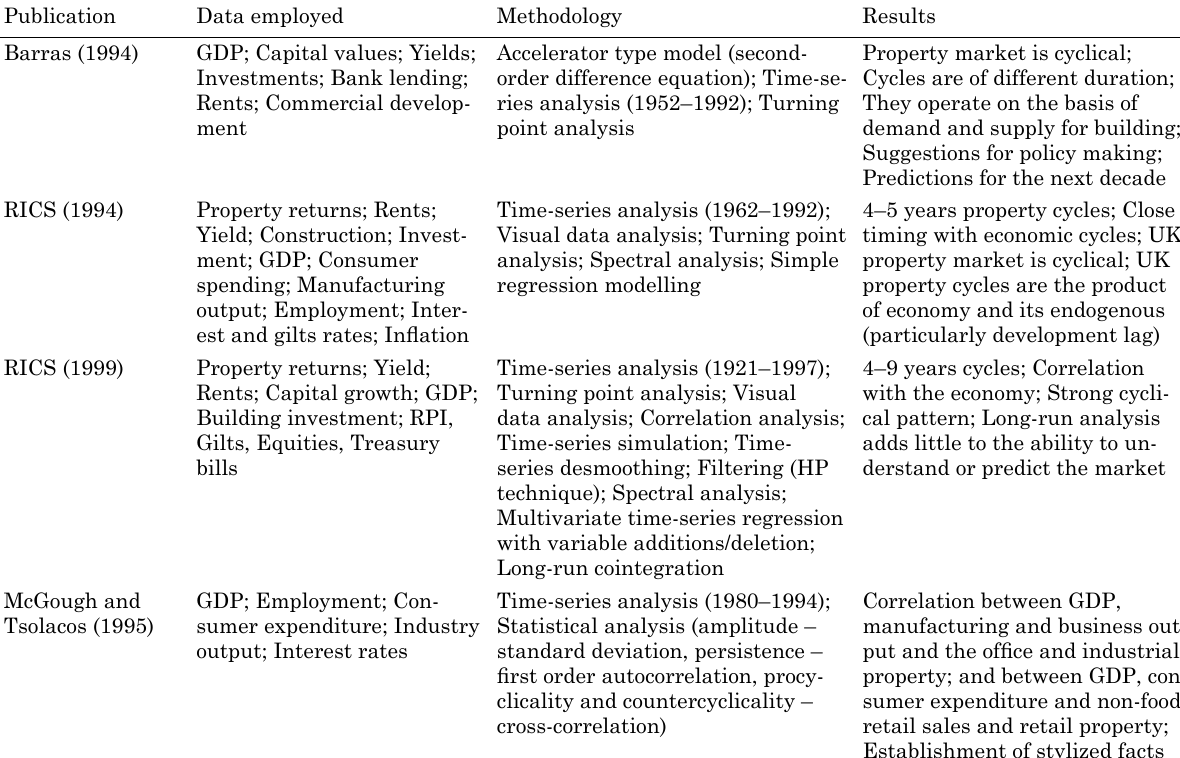
table 4. Key post-1990s crash publications on property